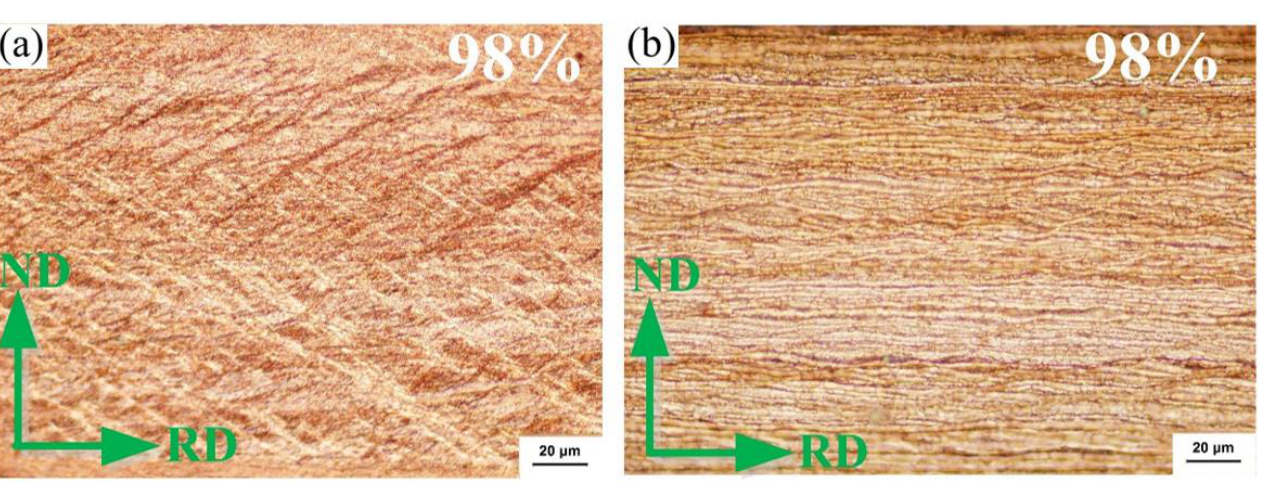
Figure 11. Longitudinal section Metallography of large deformation cold rolled alloy strip (ε = 98%). ( a ) EG strip and ( b ) CG strip.